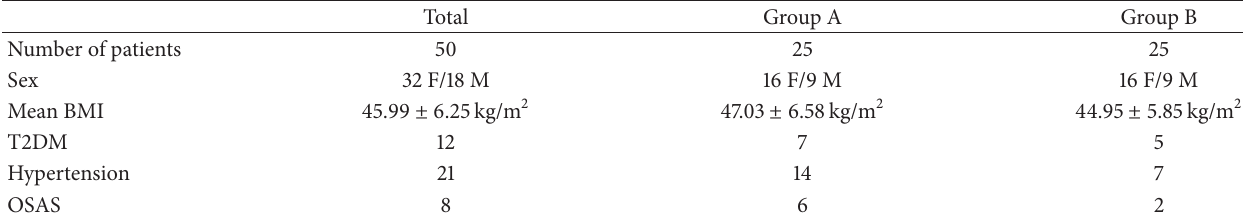
Table 1: Demographic of patients enrolled in the study.